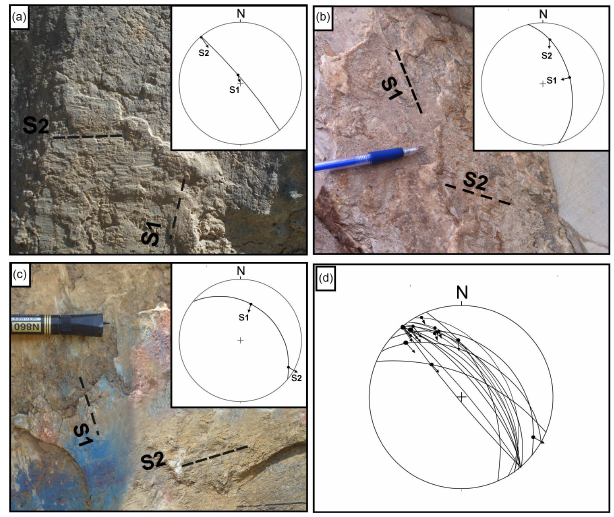
Figure 14. (a, b, c) Fault planes with two generations of striae. First generation (S1) is reverse-slip but second generation (S2) has oblique to dextral strike-slip kinematics. For the photographs’ loca- tions refer to Figs. 2 and 7; (d) lower hemisphere equal area stereo- graphic projection showing cumulative late faults in the KS area.